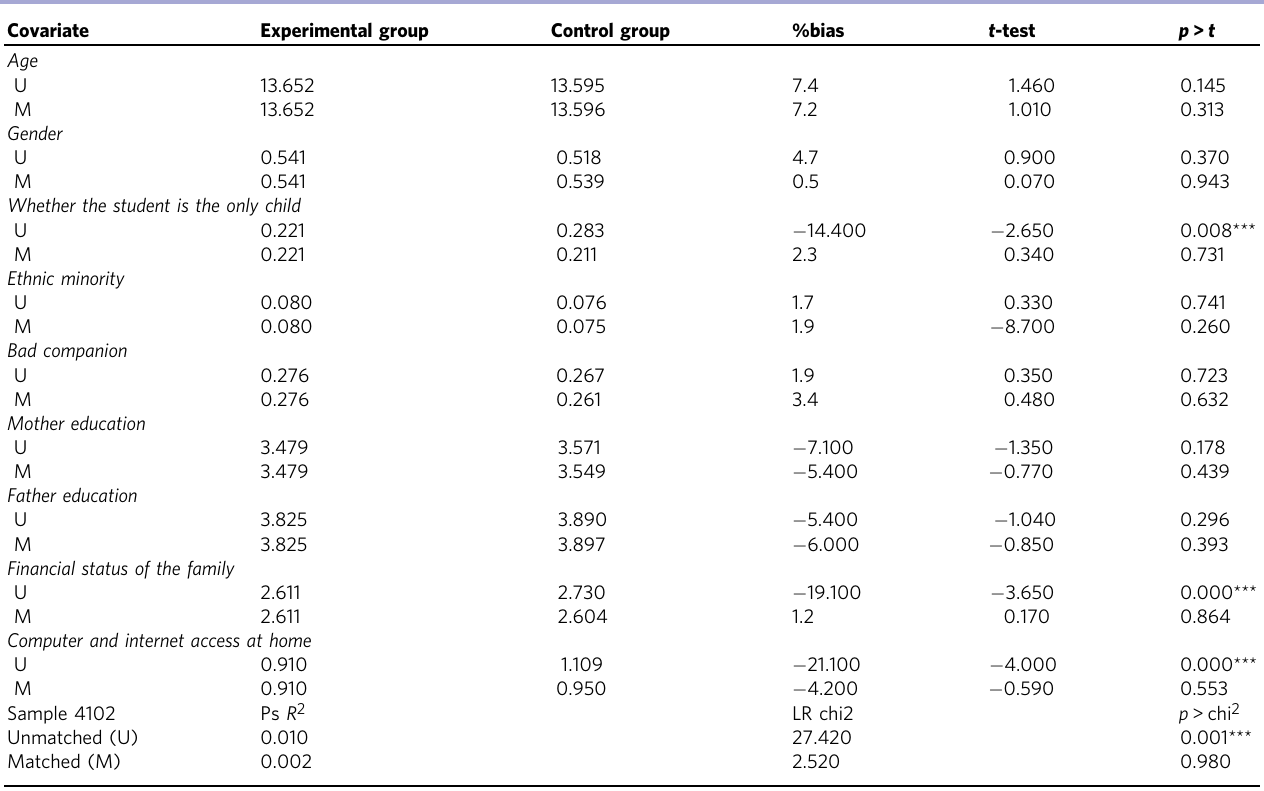
Table 4 Matching balance test on the model of only father migrates.